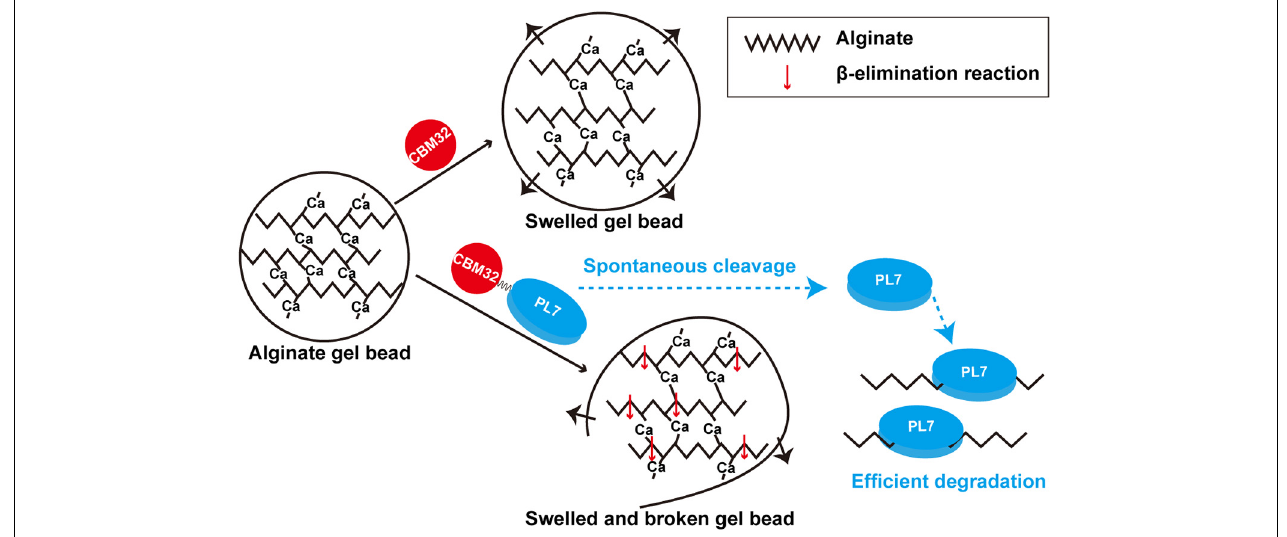
FIGURE 6 | Schematic diagram of degradation modes of soluble sodium alginate and insoluble alginate gel by